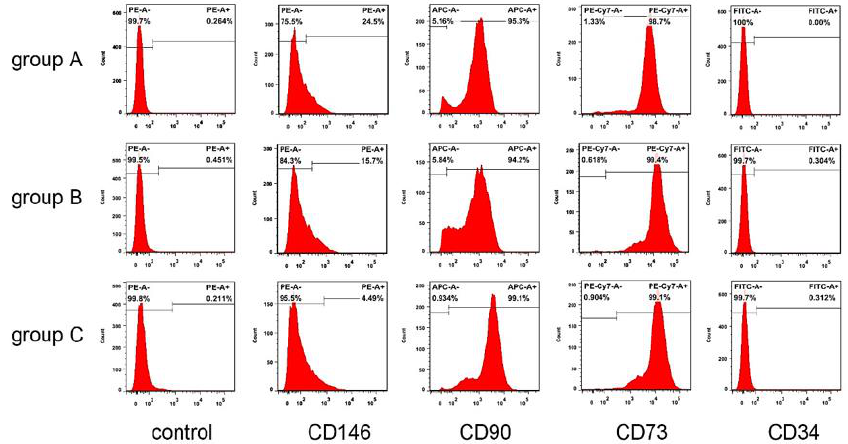
Figure 3. Expression of surface markers in the three groups. Flow cytometric analysis showed that hDPSCs were positive for CD73 (>90%), CD90 (>90%), with low expression of CD146 (<30%), and negative for CD45 (<1%).